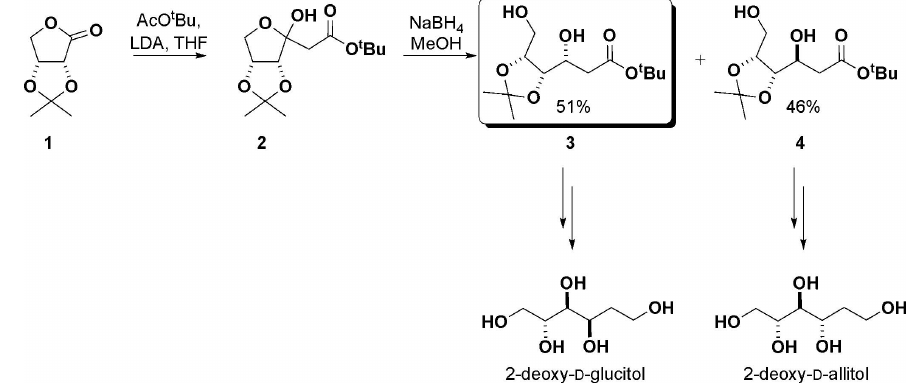
Figure 1 Synthetic scheme for the synthesis of the title compound.